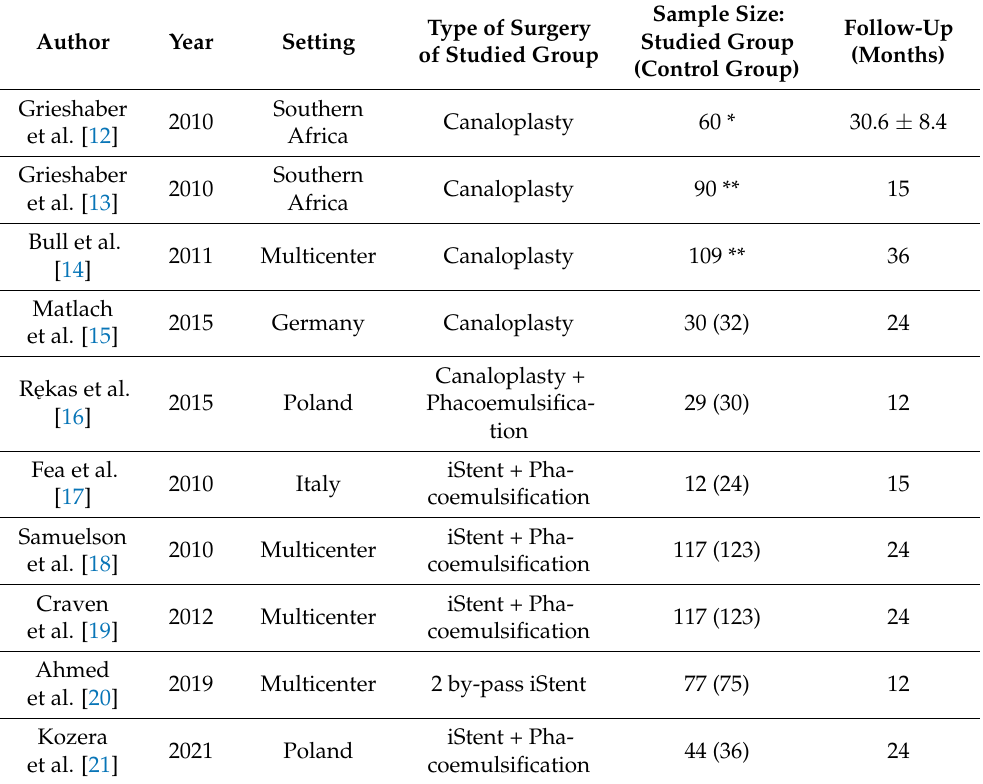
Table 1. Characteristics of the prospective randomized control trials included in the